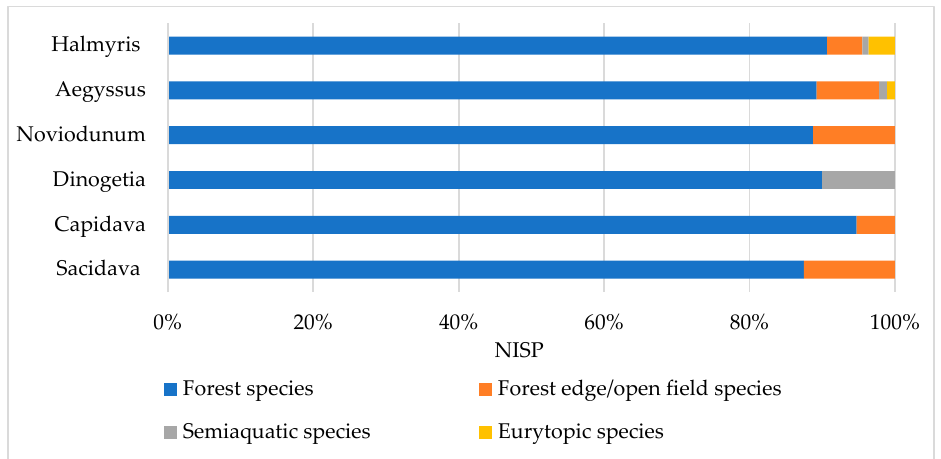
Figure 3. Proportions of species in the wild mammal group.